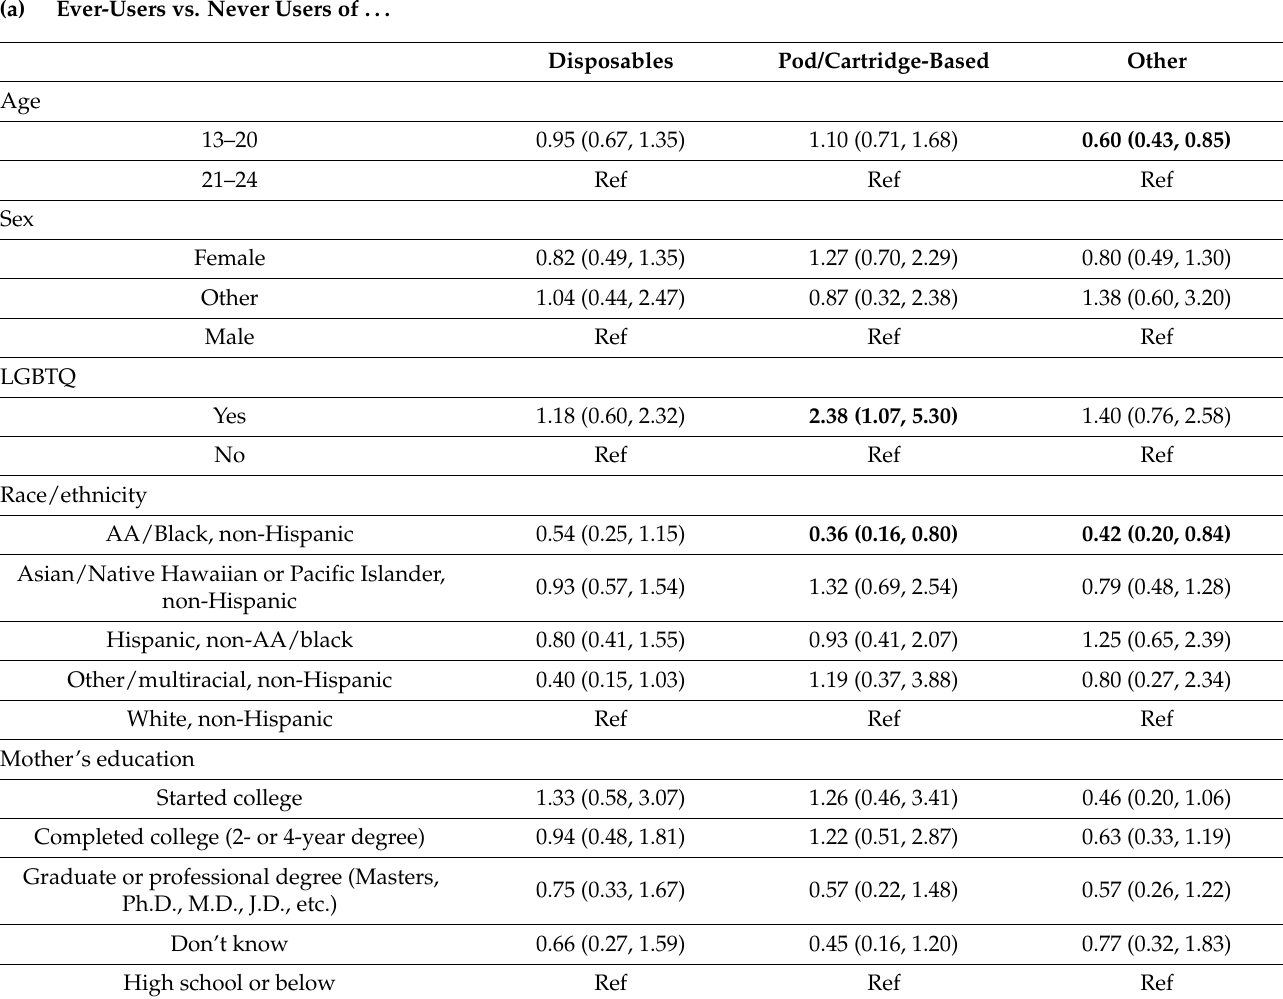
Table 2. Association between sociodemographic factors and . . . [Adjusted Odds Ratio (95%CI)] ˆ. (a) Ever-Users vs. Never Users of . .